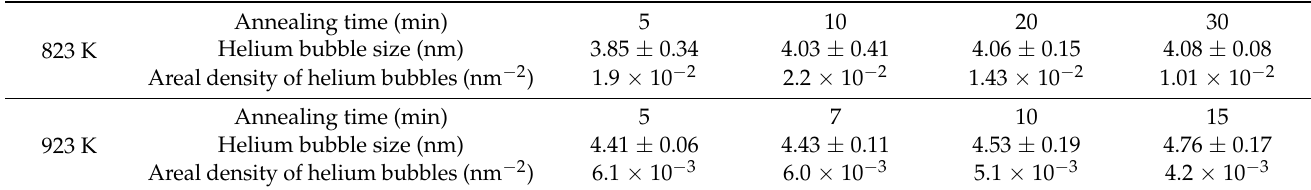
Table 1. The size of helium bubbles under different annealing times at 823 K and 923 K.